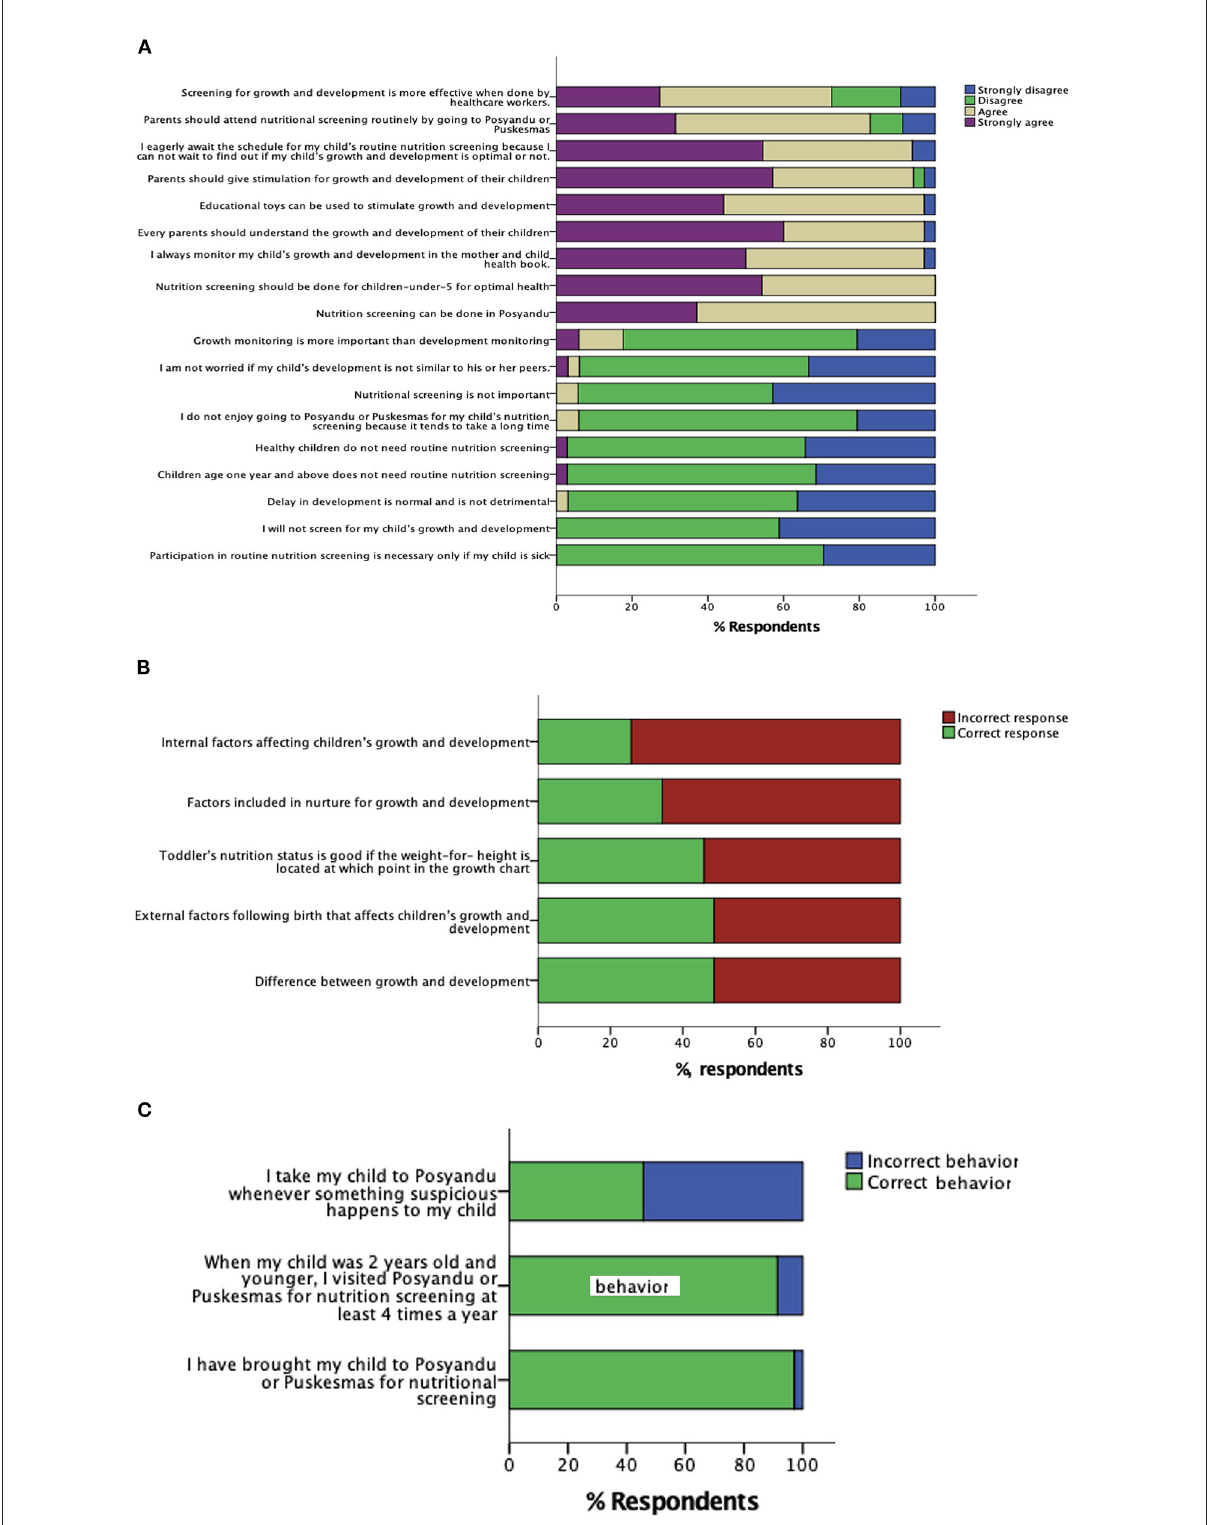
FIGURE2 Participants’ responses for baseline (A) attitude, (B) knowledge*, and (C) behavior ( n = 35) on monitoring children’s growth and development and utilization of Posyandu as growth and development monitoring facilities. *Only 5 questions with the highest proportion of incorrect responses were represented in the